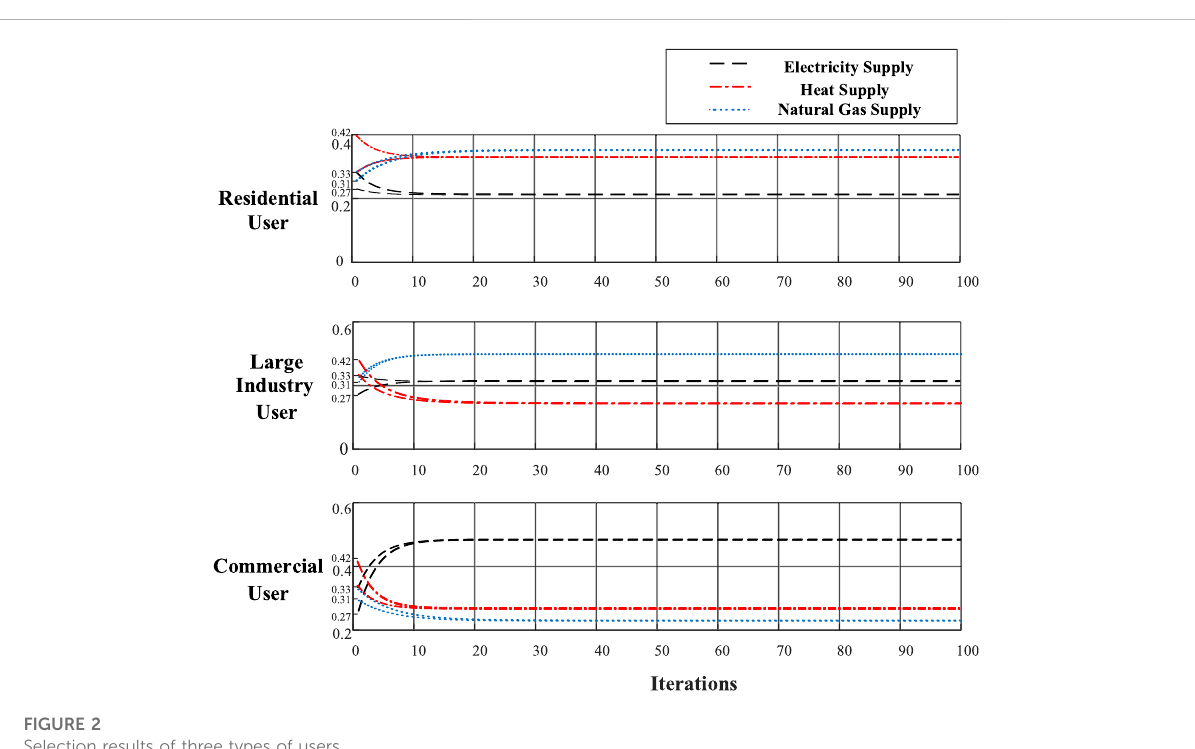
FIGURE 2 Selection results of three types of